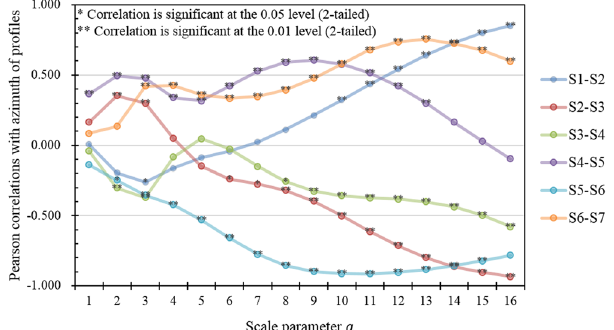
Figure 7. Pearson correlation of the WCMVs between the shoreline changes and azimuth of the profiles from HNJ to